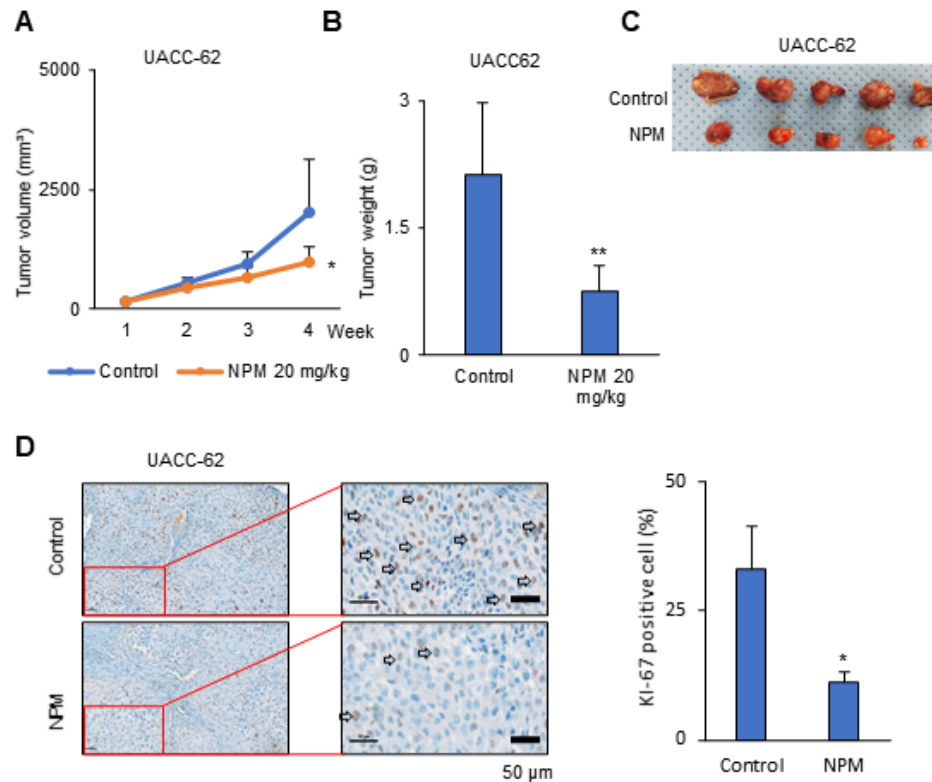
Figure 4. Tumor growth in a melanoma xenograft model was inhibited by NPM treatment. ( A ) The graph represents the tumor growth, as measured using calipers. ( B ) The weight of subcutaneous UACC-62 tumors from mice with or without NPM treatment. ( C ) Representative images of the removed tumors. ( D ) Immunohistochemical analysis of Ki-67 in UACC-62 xenografts from mice with or without NPM treatment. Quantification was measured by positive cell counting using Image J. Data represent the mean and standard deviation of three independent experiments. * p < 0.05 and ** p < 0.01 compared with the vehicle control. KI-67 positive cell was checked by arrow.